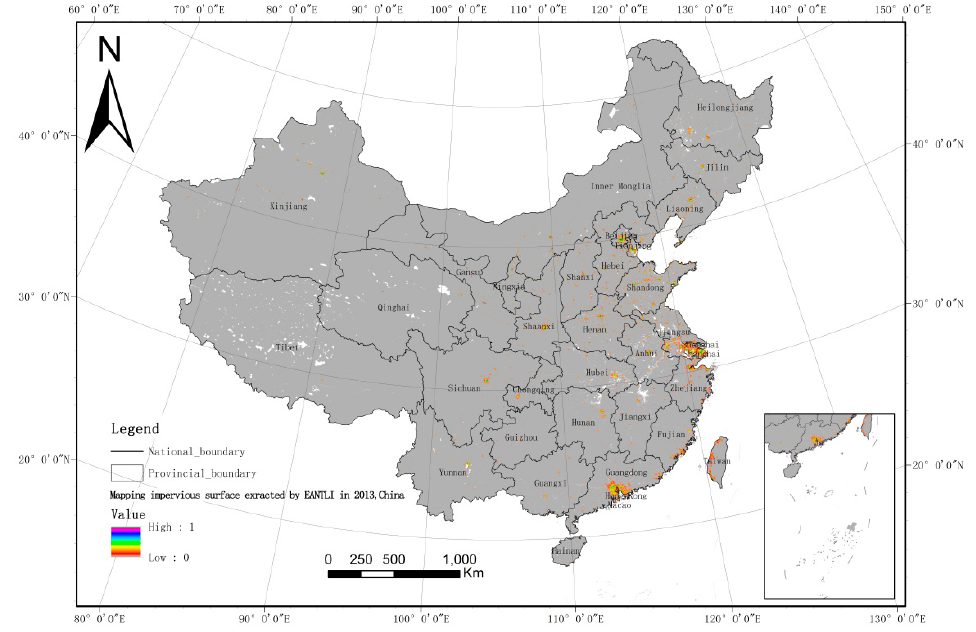
Figure 4. Urban impervious area distribution map in 2013. 374